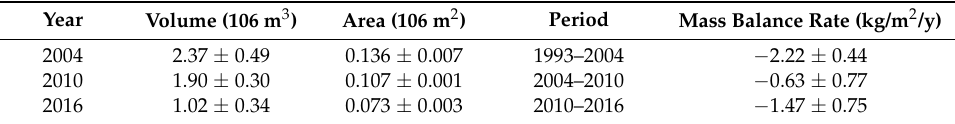
Table 5. Volume change and mass balance rate of Lewis Glacier 2004–2016. Values for the period 2004–2010 were taken from [12]. Error ranges were derived from error propagation using horizontal and vertical accuracies from [12,13] and this